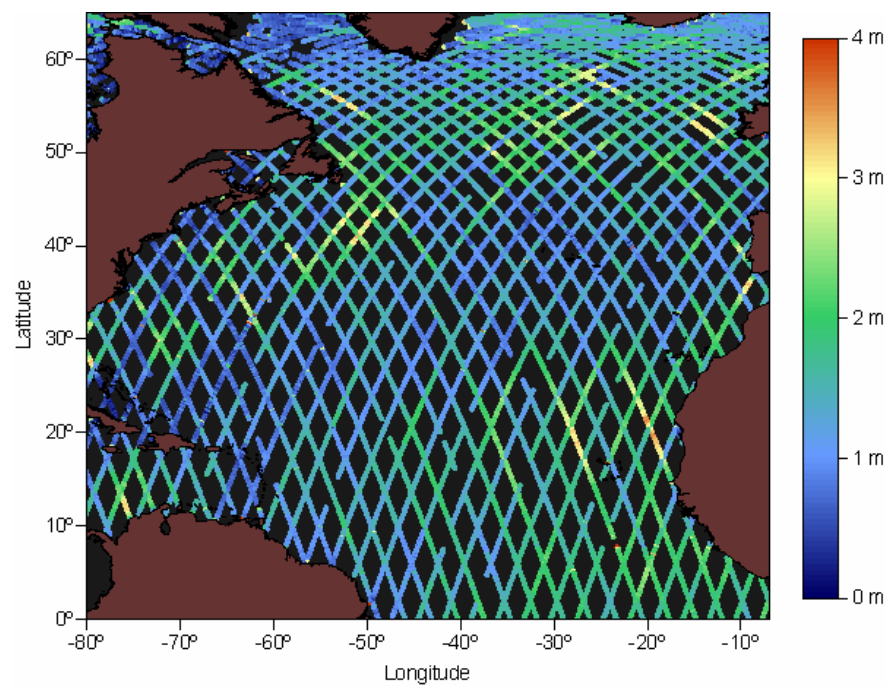
Figure 16a. Significant wave height for cycle 364 (August 2002).